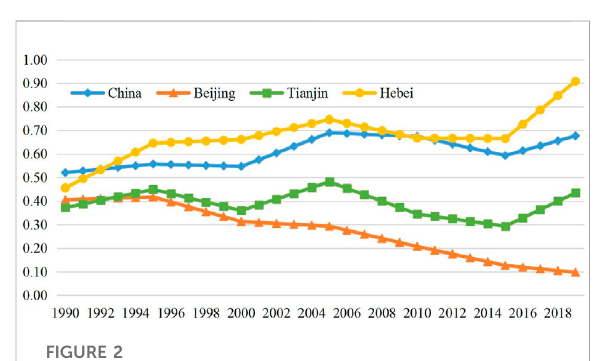
FIGURE 2 Ec of Beijing-Tianjin-Hebei region and China from 1990 to 2019 (Unit: hm2/person).